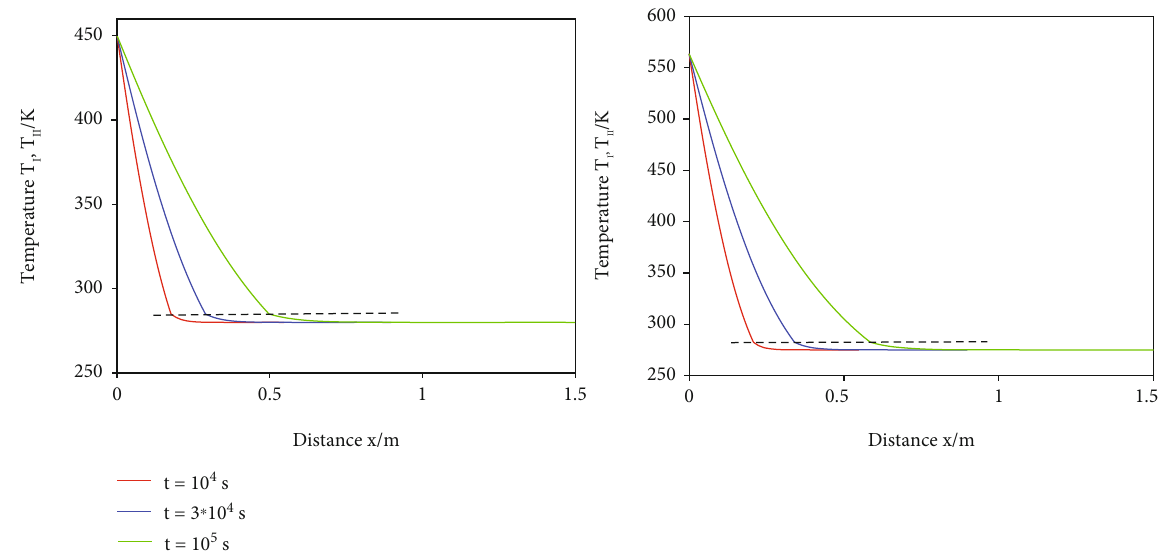
Figure 2: The temperature of steam and hot water varies with